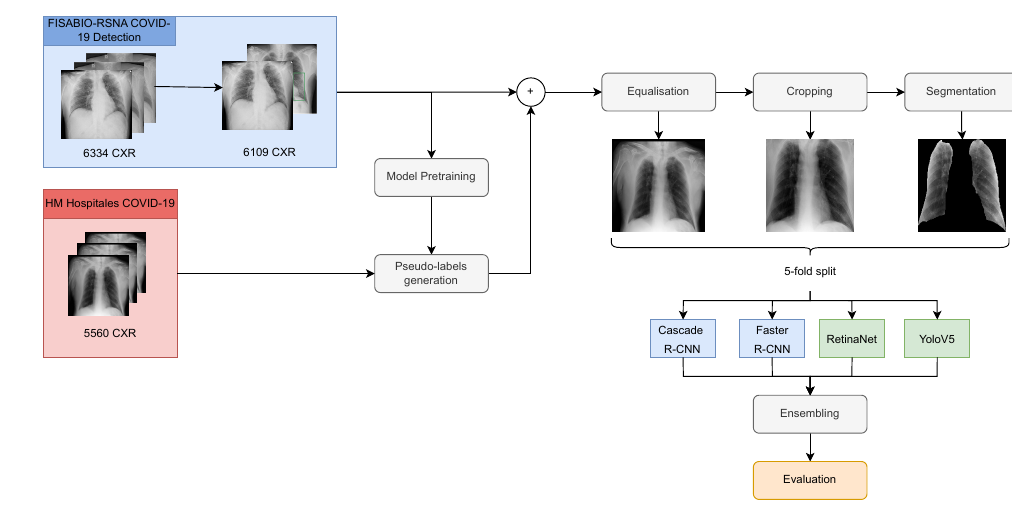
Figure 4. Schematic view of the procedure